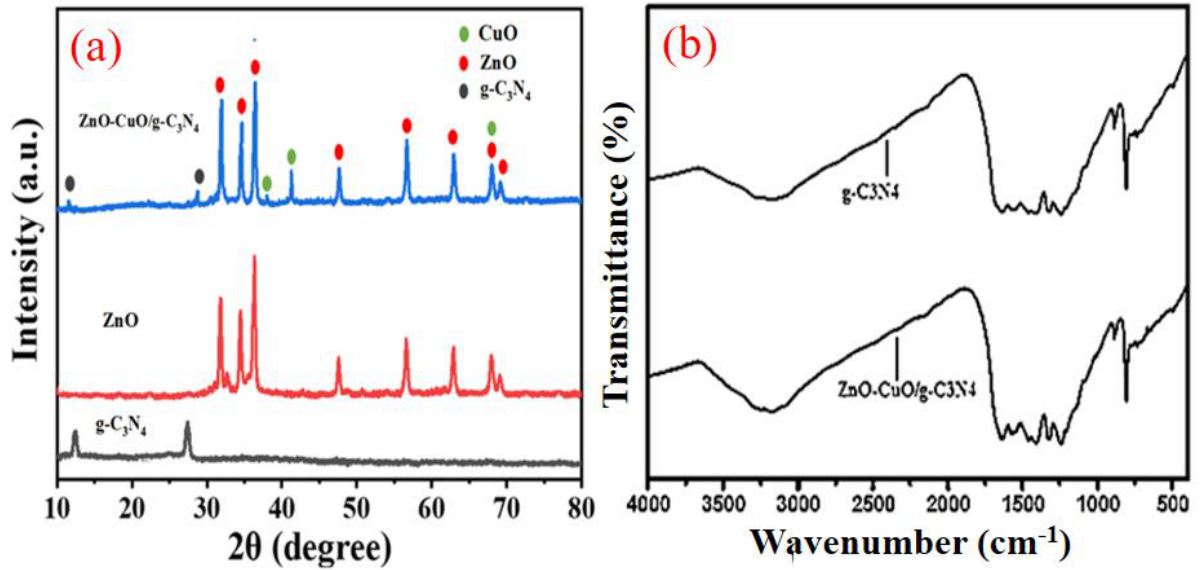
Figure 1. (a) XRD patterns of g – C 3 N 4 , ZnO and ZnO – CuO/g – C 3 N 4 samples, ( b ) FTIR spectra of the Figure 1. ( a ) XRD patterns of g–C 3 N 4 , ZnO and ZnO–CuO/g–C 3 N 4 samples, ( b ) FTIR spectra of the g – C 3 N 4 and prepared composite ZnO – CuO/g – C 3 N 4 . g–C 3 N 4 and prepared composite ZnO–CuO/g–C 3 N 4